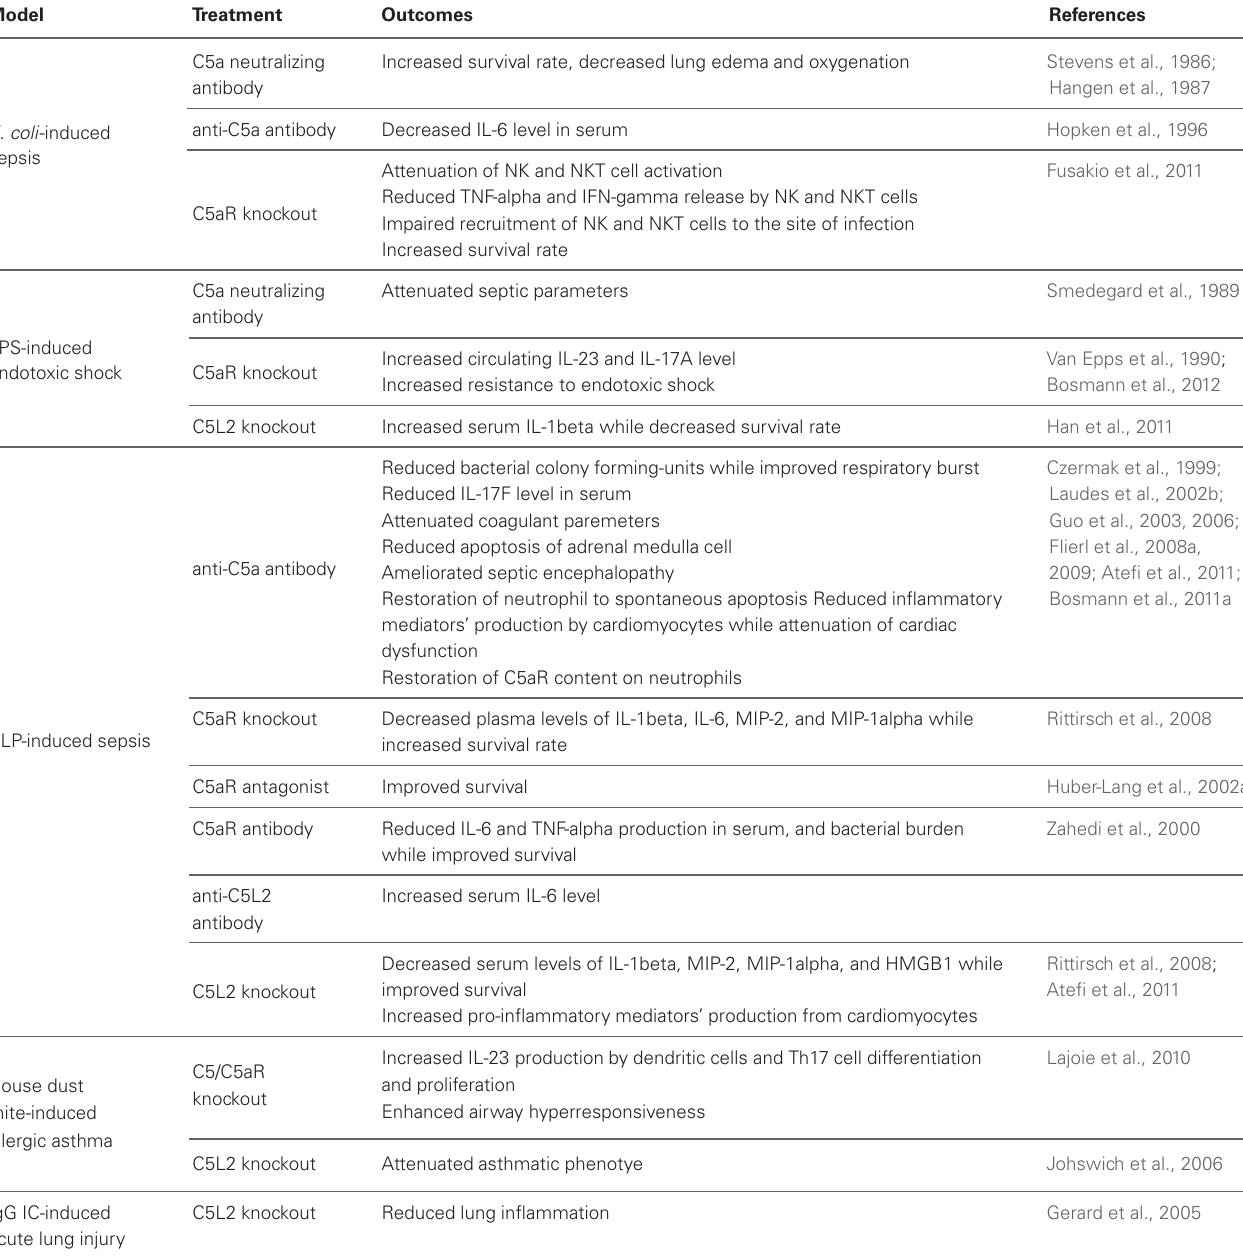
Table 2 | In vivo immunoregulatory properties of the C5a/C5aR